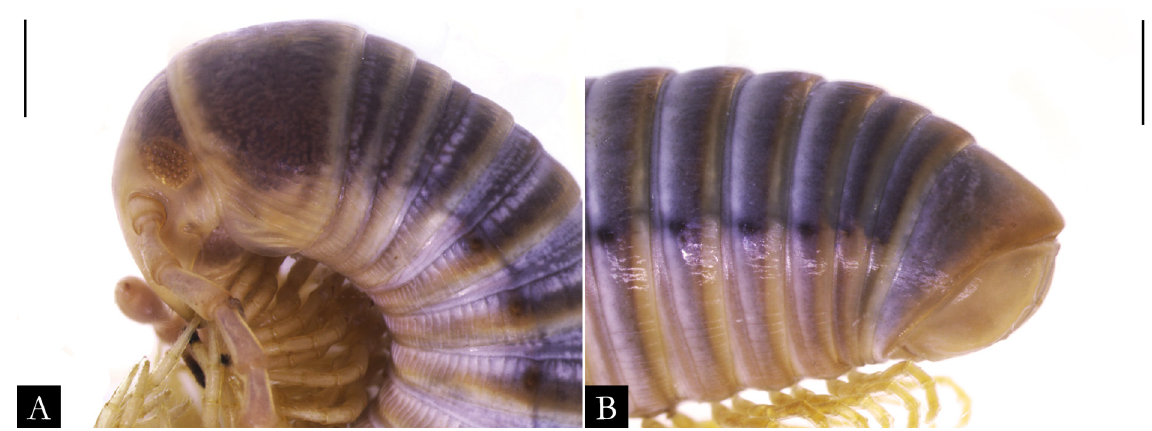
Fig. 121. Pseudonannolene sebastianus Brölemann, 1902, ♀ (IBSP 1110), in lateral view. A . Anterior region. B . Posterior region. Scale bars = 0.5